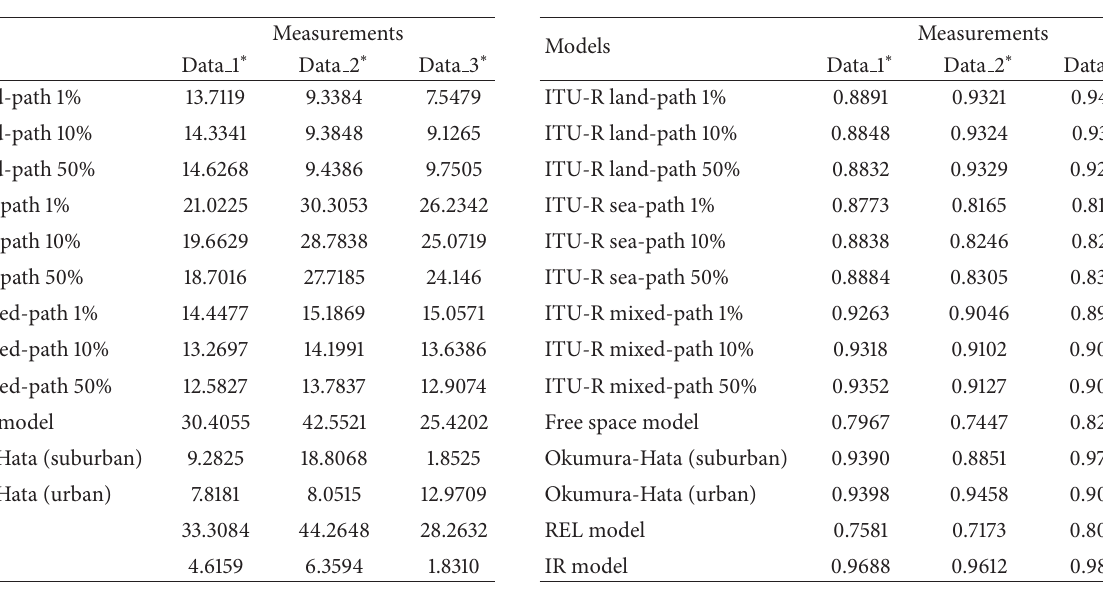
Table 4: The PCC-MAPE model selection